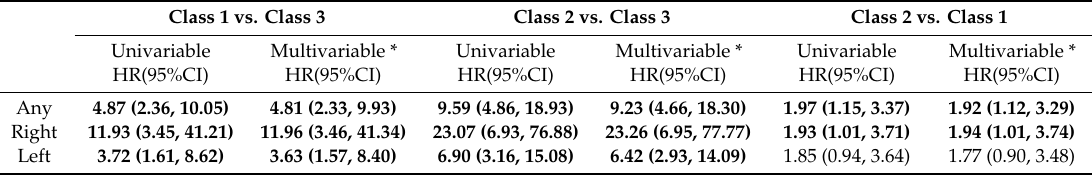
Table 3. Identified pain phenotypes and knee joint